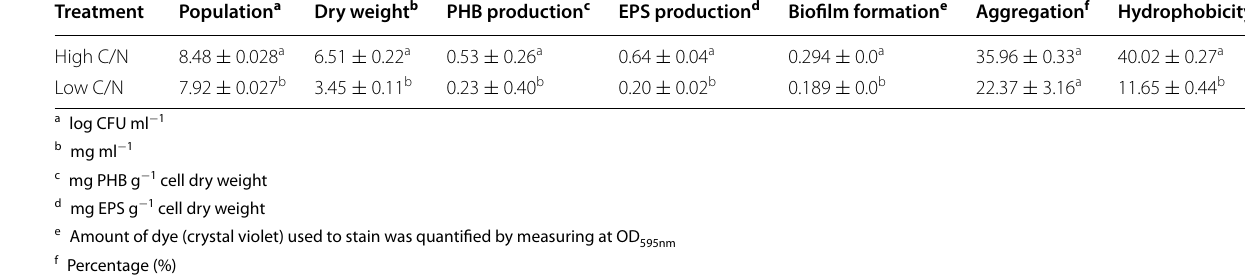
Table 1 Cell growth and physiological characteristics of aggregated and non-aggregated M. oryzae CBMB20 cells